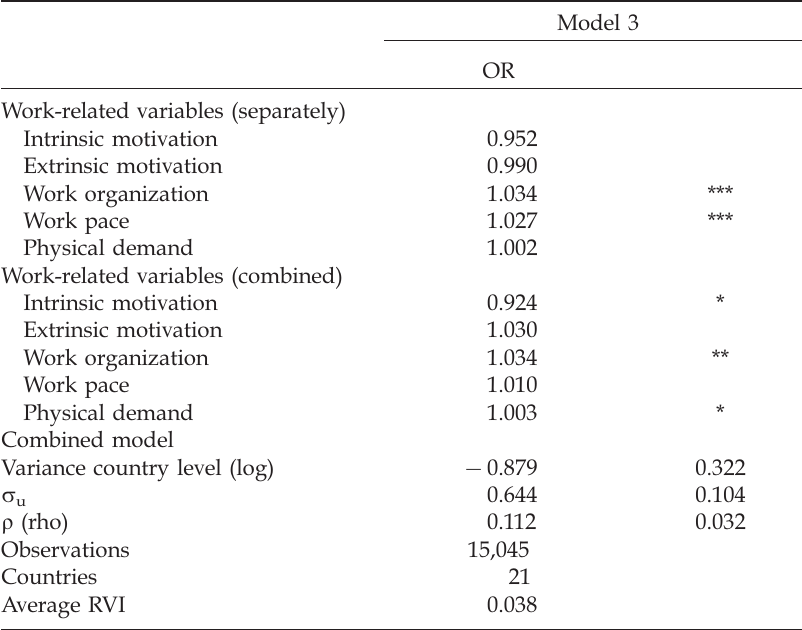
Table 2. Odds ratios, multile v el logistic regression on participation (0/1), results for original sample and ele v en imputed models (N (cid:3)